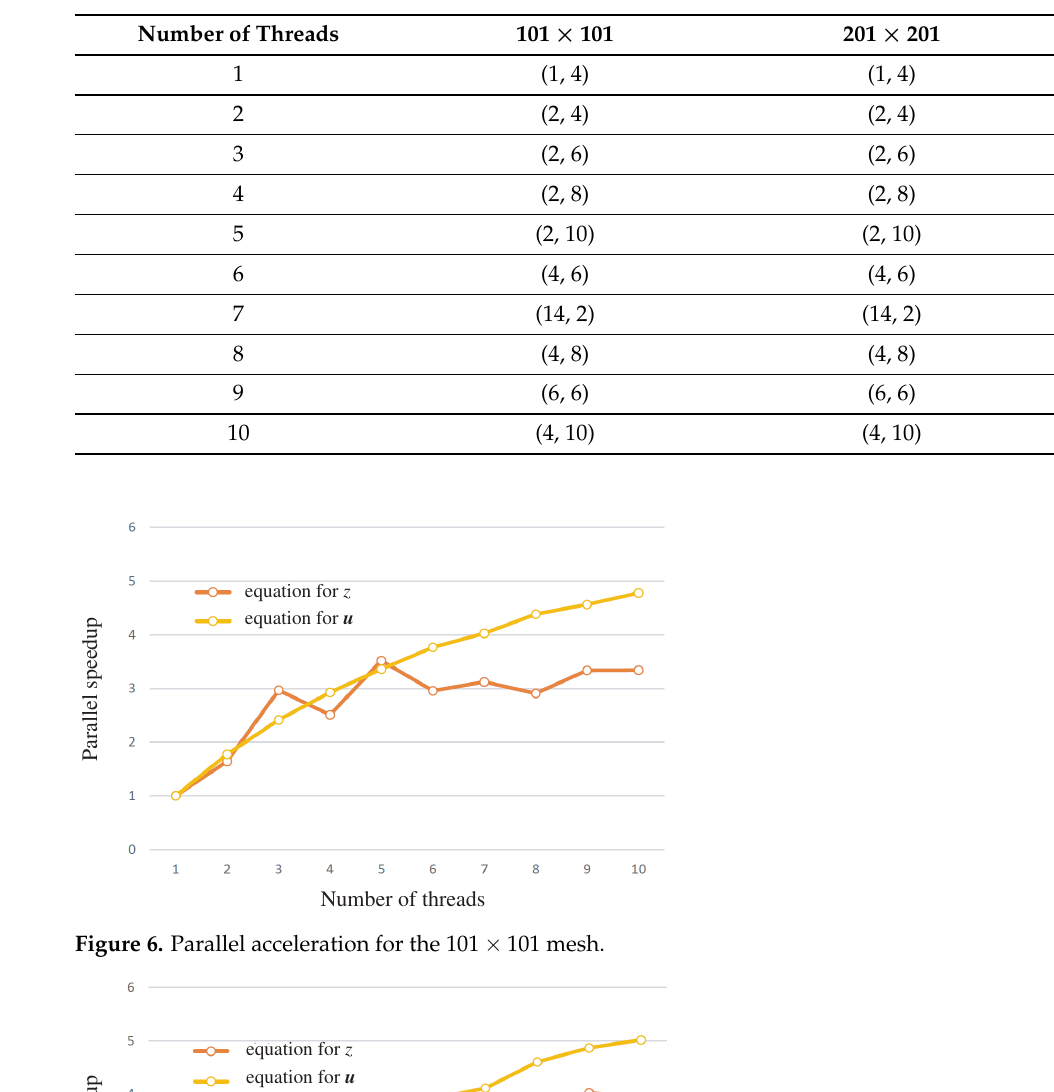
Table 2. Optimal combinations of nbx and nby .